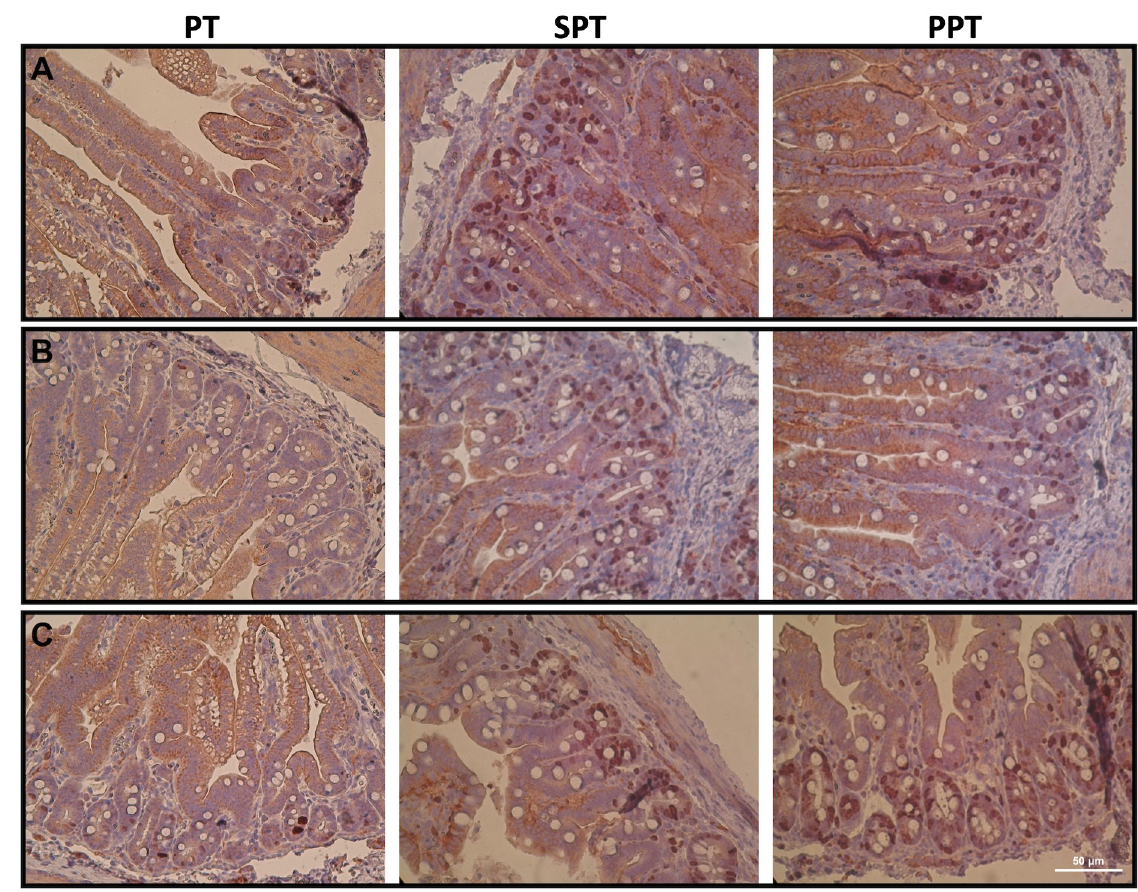
Fig 3. Changes in intestinal crypt stem cell proliferative activity. PT—14-day old intact, control preterm piglets, SPT—preterm piglets fed infant formula, PPT—preterm piglets fed pre-hydrolyzed infant formula. The images show stained Ki67 positive cells (3,3 0 -diaminobenzidine staining, colour—brown) prone to mitotic division. A—proximal, B—middle, C—distal, section of the jejunum. Hematoxylin-stained cell nucleus (colour—blue). Images were obtained using a light microscope (Axioskop 40, Zeiss, Germany, magnification—400 × ).